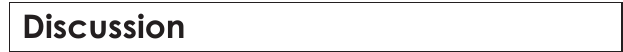
Table III. Criteria used to screen referral letters regarding patients' medical and psychiatric history